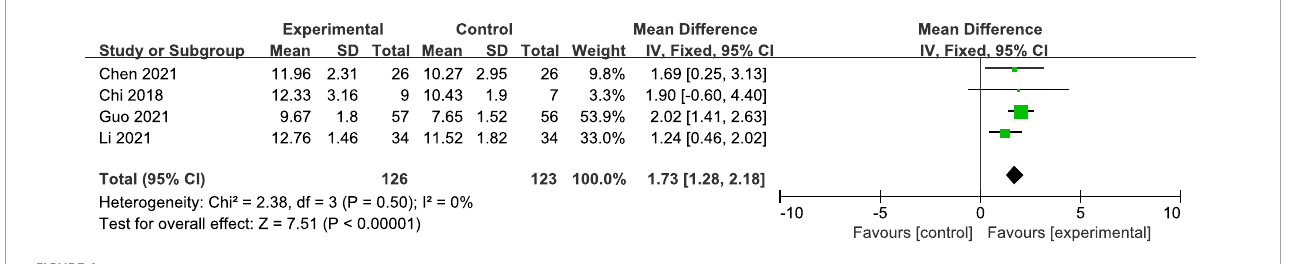
FIGURE4 Meta-analysis of all studies on GCS scores in patients with DOC.